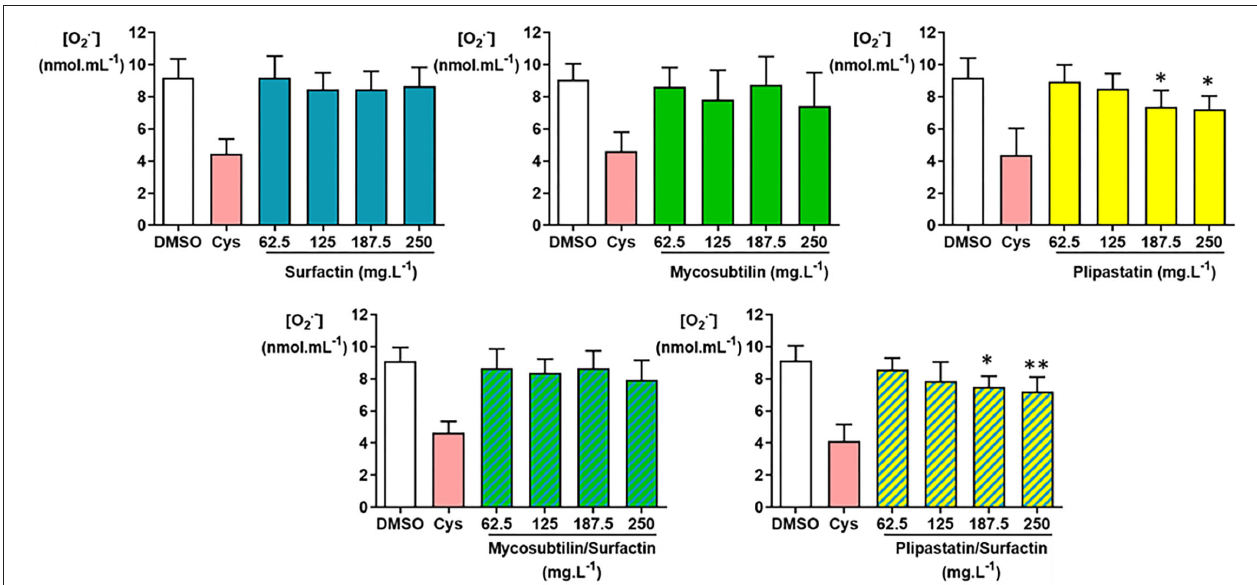
FIGURE 3 | Inhibition of the superoxide anion (O . − 2 ) by the following lipopeptides (surfactin, mycosubtilin, plipastatin, mixture of mycosubtilin/surfactin, and mixture of plipastatin/surfactin) at increasing concentrations in a cell-free model. The effects on O . − 2 of lipopeptides tested at concentrations between 62.5 and 250mg.L − 1 (for the mixture, the indicated concentrations correspond to the concentration of each of the two lipopeptides) were compared to those of the DMSO-negative control. The positive control for O . − 2 inhibition was cysteine (Cys) at 0.3 mmol.L − 1 . Statistical analysis of the data was performed on 6 independent experiments using ANOVA (overall Fisher’s test at the p = 0.05 level and Tukey’s multiple a posteriori comparison test) for mycosubtilin, plipastatin, mycosubtilin/surfactin, and plipastatin/surfactin and using the Kruskal-Wallis test (Dunn’s multiple a posteriori comparison test) for surfactin, with the GraphPad Prism software, * p < 0.05, ** p < 0.01). Results are presented as a bar graph (means ±